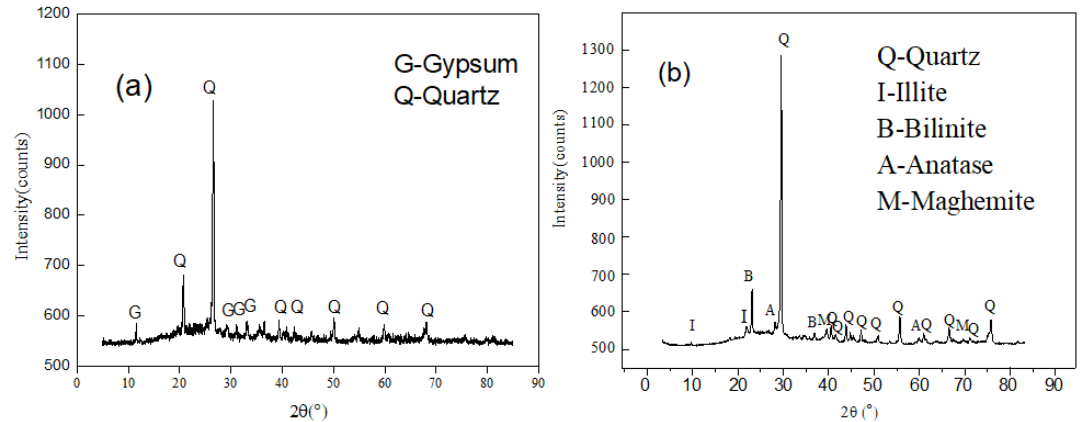
Figure 3. Figure 3 Fabricated UWB-MIMO antenna: ( a ) front view; ( b ) rear view. 3.1. Decoupling Structure for Side-by-Side Radiators The dumbbell shaped stub attached to the ground plane provides isolation between side-by-side radiating elements. The circles are etched in the center of the dumbbell structure and semi-circles are subtracted from its sides in order to e ff ectively introduce the desired capacitive and inductive loading of the ground plane. The decoupling structure is shown in Figure 1a. Replicas of these stubs are placed on the top side between antennas as well. These strips, on the top side, act as transmission line resonators and e ff ectively reduce the mutual coupling between the side-by-side radiating elements. Decoupling performance better than 20 dB is achieved between side-by-side antennas.